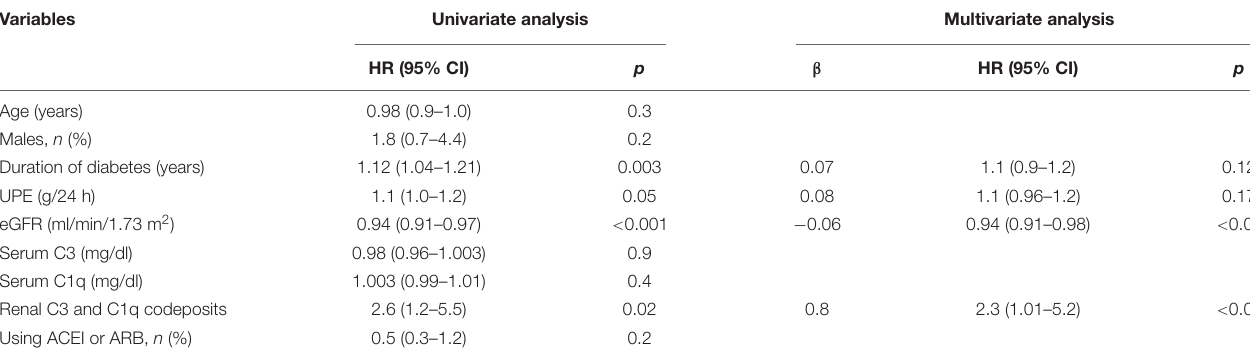
TABLE 4 | Univariate and multivariate Cox regression analysis between baseline variables and definitive renal outcome. Variables Univariate analysis